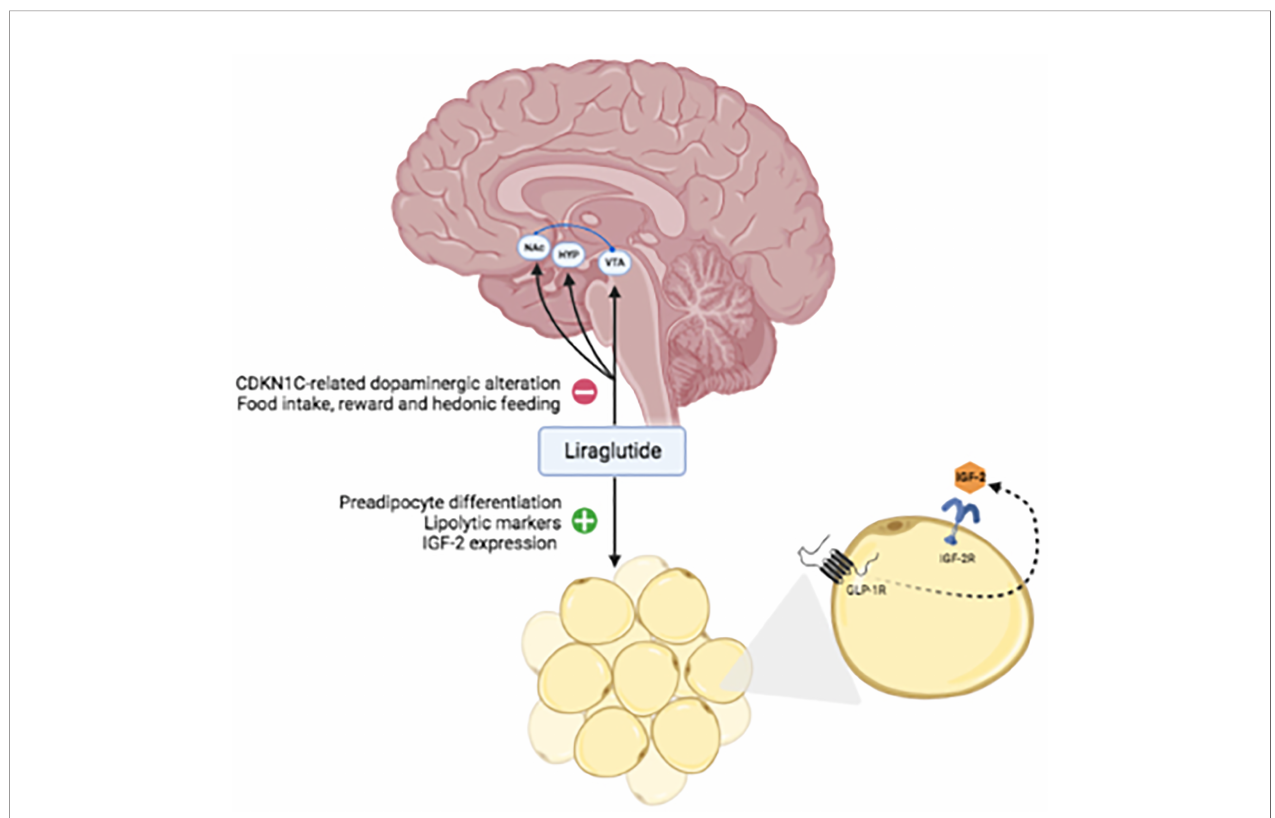
FIGURE 3 | Hypothetical mechanisms targeted by liraglutide in BWS. Abbreviations: VTA, ventral tegmental area; NAc, nucleus accumbens; HYP, hypothalamus; IGF, insulin-like growth factor; IGF-2R, insulin-like growth factor 2 receptor; GLP1-R, glucagon-like